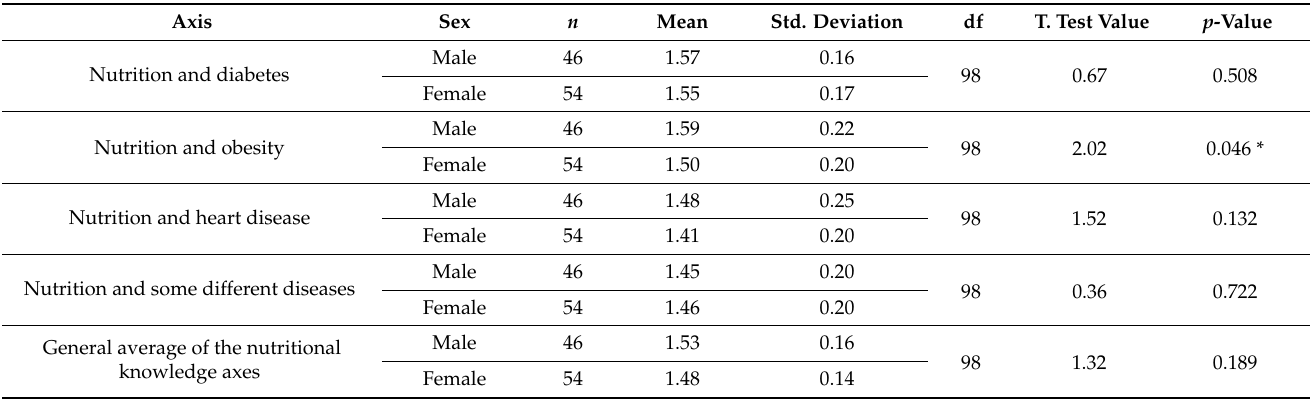
Table 3. Differences between the average responses of the study participants by sex and nutritional knowledge using independent-sample test.